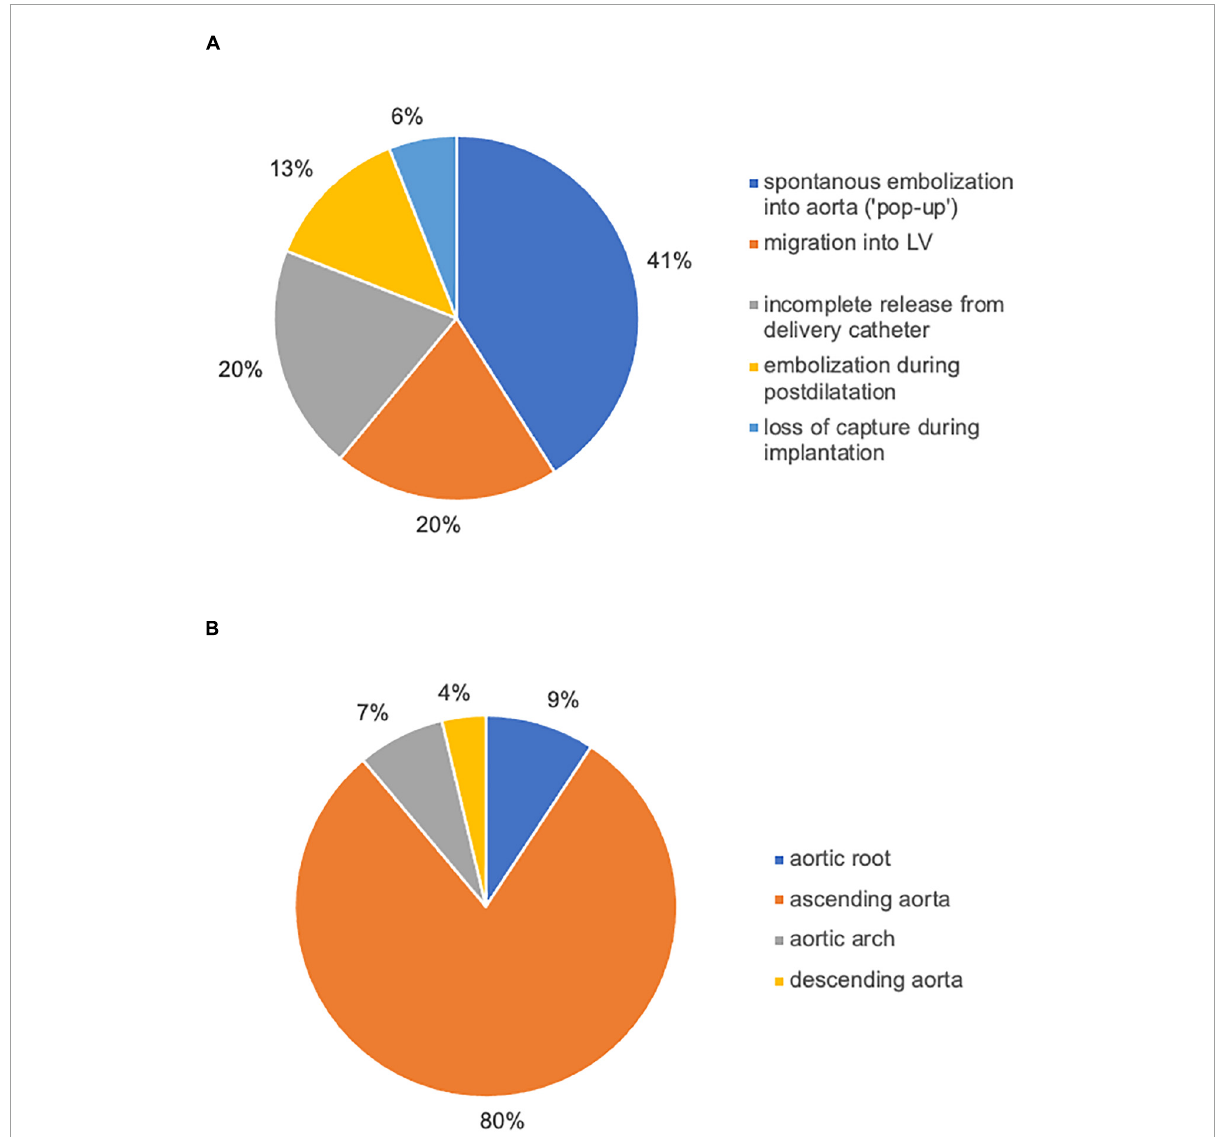
FIGURE1 Causes of TVEM and the final position of embolized valves left in situ . Review of procedural records and angiograms identified five main mechanisms of TVEM during TAVI (A) . In the majority of cases, the embolized THV was left in the ascending aorta (B) .